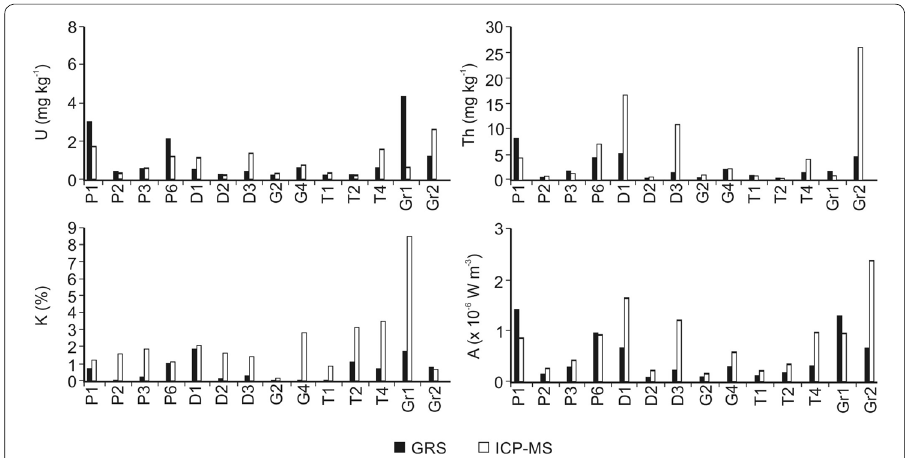
Fig. 6 Comparison of radiogenic element concentration between gamma-ray spectrometry (GRS) and